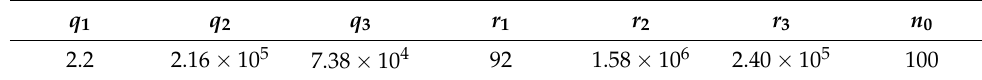
Table 2. Parametric values of the MR damper model.